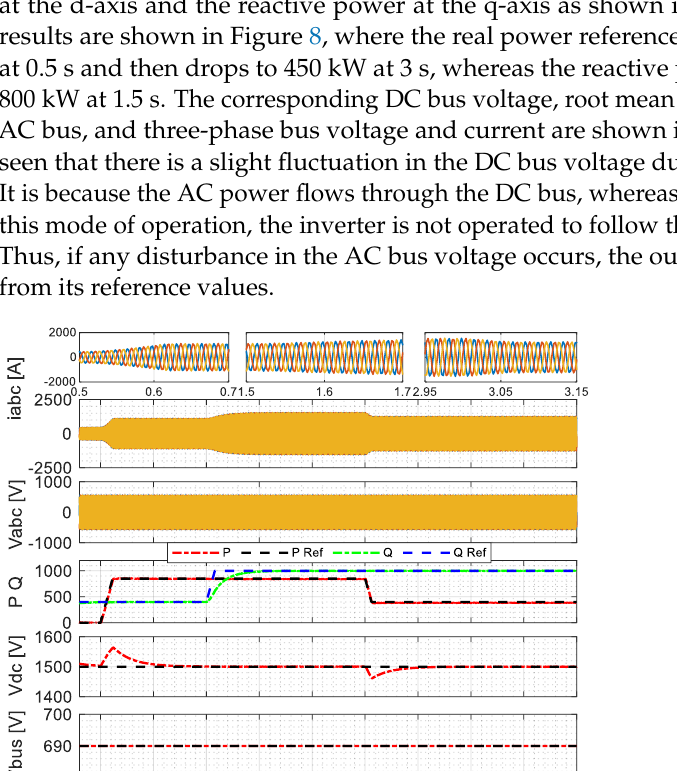
Figure 9. PCC voltage control operation results.